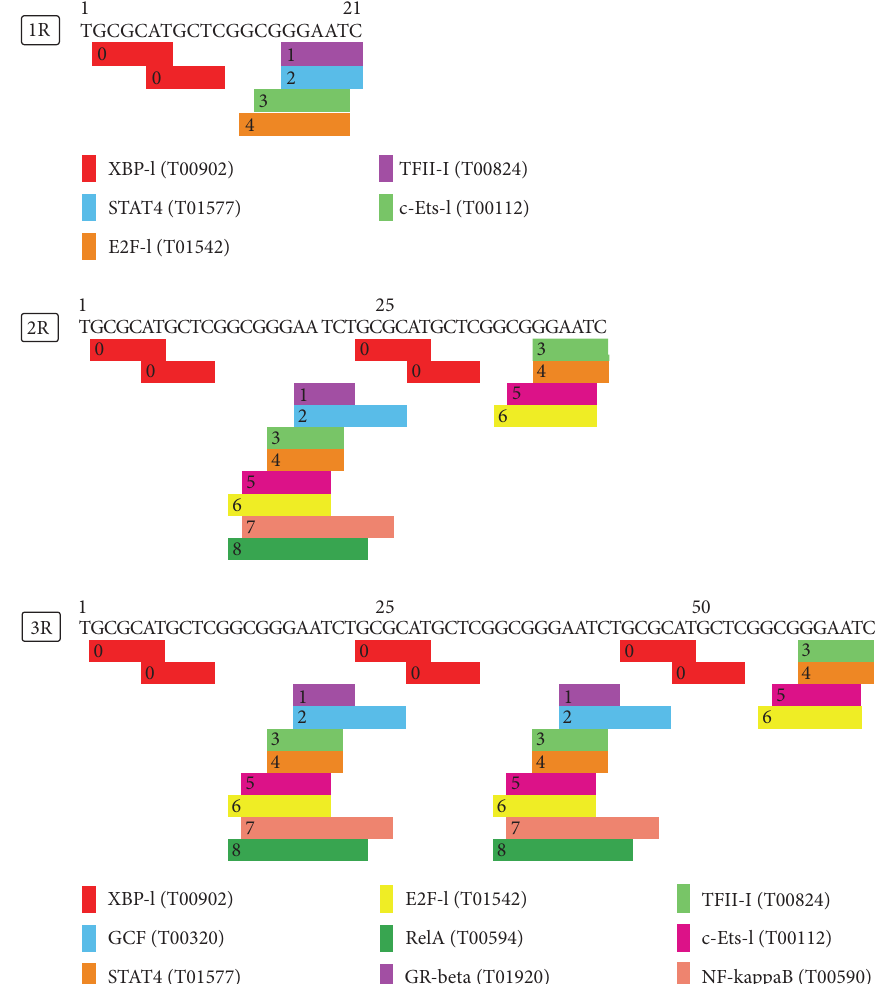
Figure 4: Potential binding sites for transcription factors of 1R, 2R, and 3R tandem repeat elements of the XRCC5 VNTR: XBP-1=X-box binding protein 1; TFII-I =transcription factor II-I; STAT4 =signal transducer and activator of transcription 4; c-Ets-1 =c-E-twenty-six-1; E2F-1=E2F transcription factor 1; GR-beta=glucocorticoid receptor-beta; GCF=GC factor; NF-kappaB =nuclear factor-kappaB; RelA =v-rel avian reticuloendotheliosis viral oncogene homolog